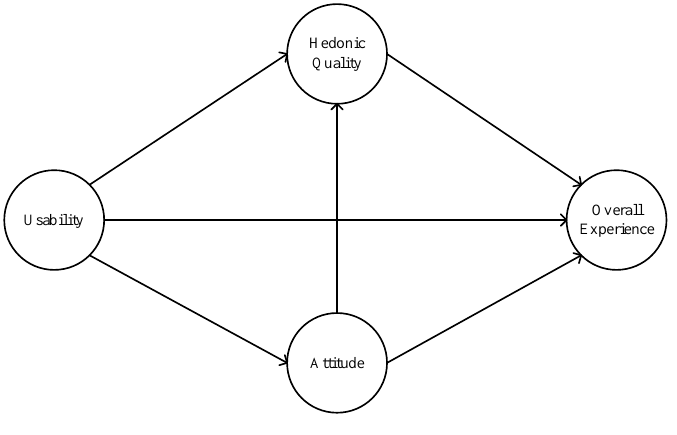
Figure 1. Research